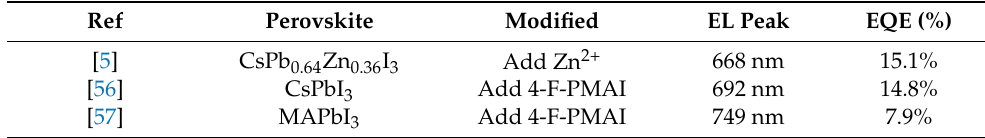
Table 4. Component parameter arrangement in the orange and red light